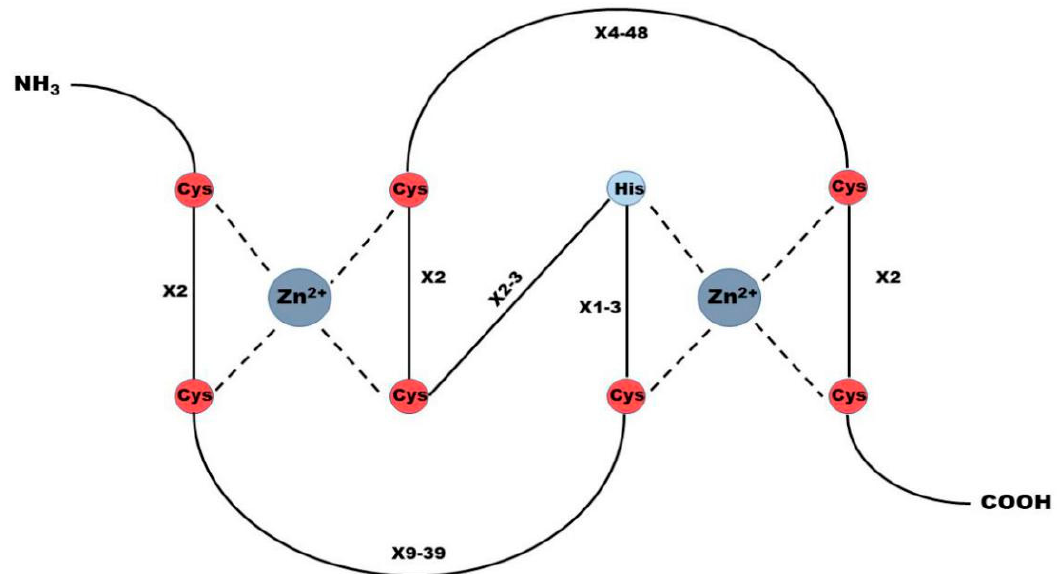
Figure 2. Structure of RING E3 ubiquitin ligase. RING finger motif is an essential factor to ensure that RING E3s has the function of ubiquitin ligase. It is composed of 40–60 residues, of which 8 spatially conserved amino acid residues are arranged in the order of Cys-X2-Cys-X(9–39)-Cys-X(1–3)-His-X(2–3)-Cys-X2-Cys-X(4–48)-Cys-X2-Cys (X represents any residue, His and Cys can be exchanged). The domain formed by this residue can chelate two zinc ions and provide a binding platform for E2 enzyme.